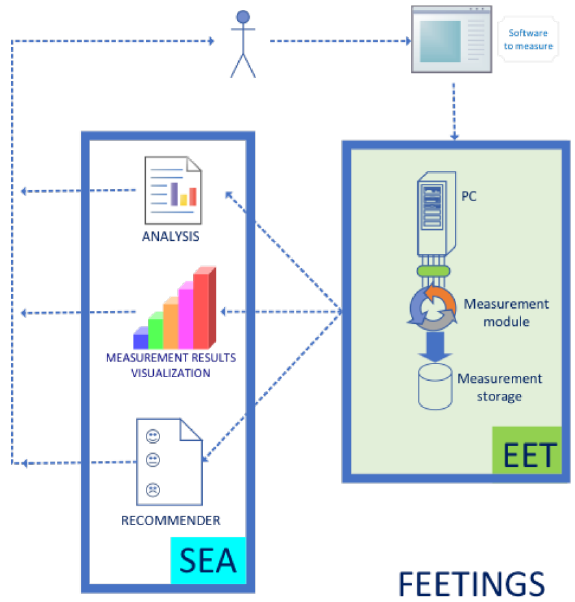
Figure 3. Whole FEETINGS